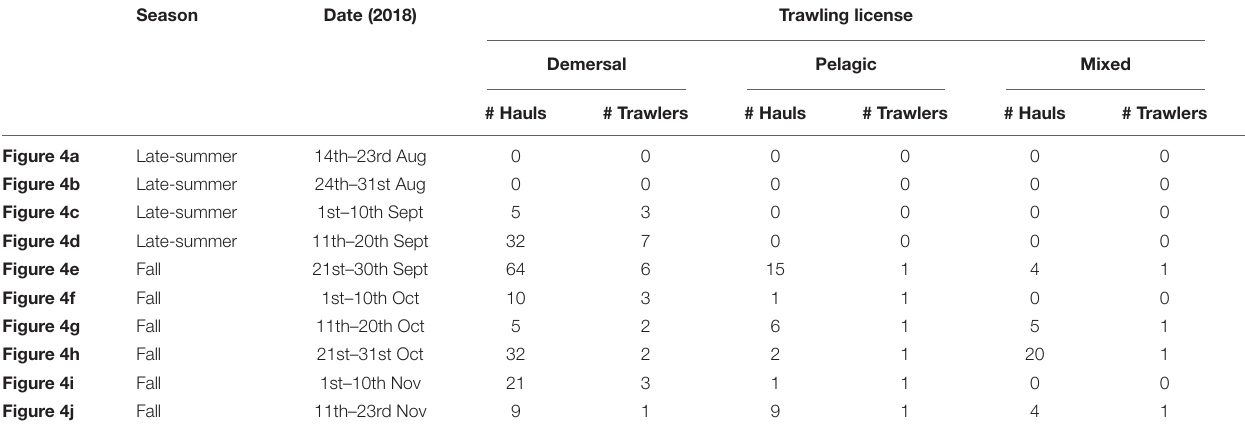
The first column indicates the correspondence with Figure 4